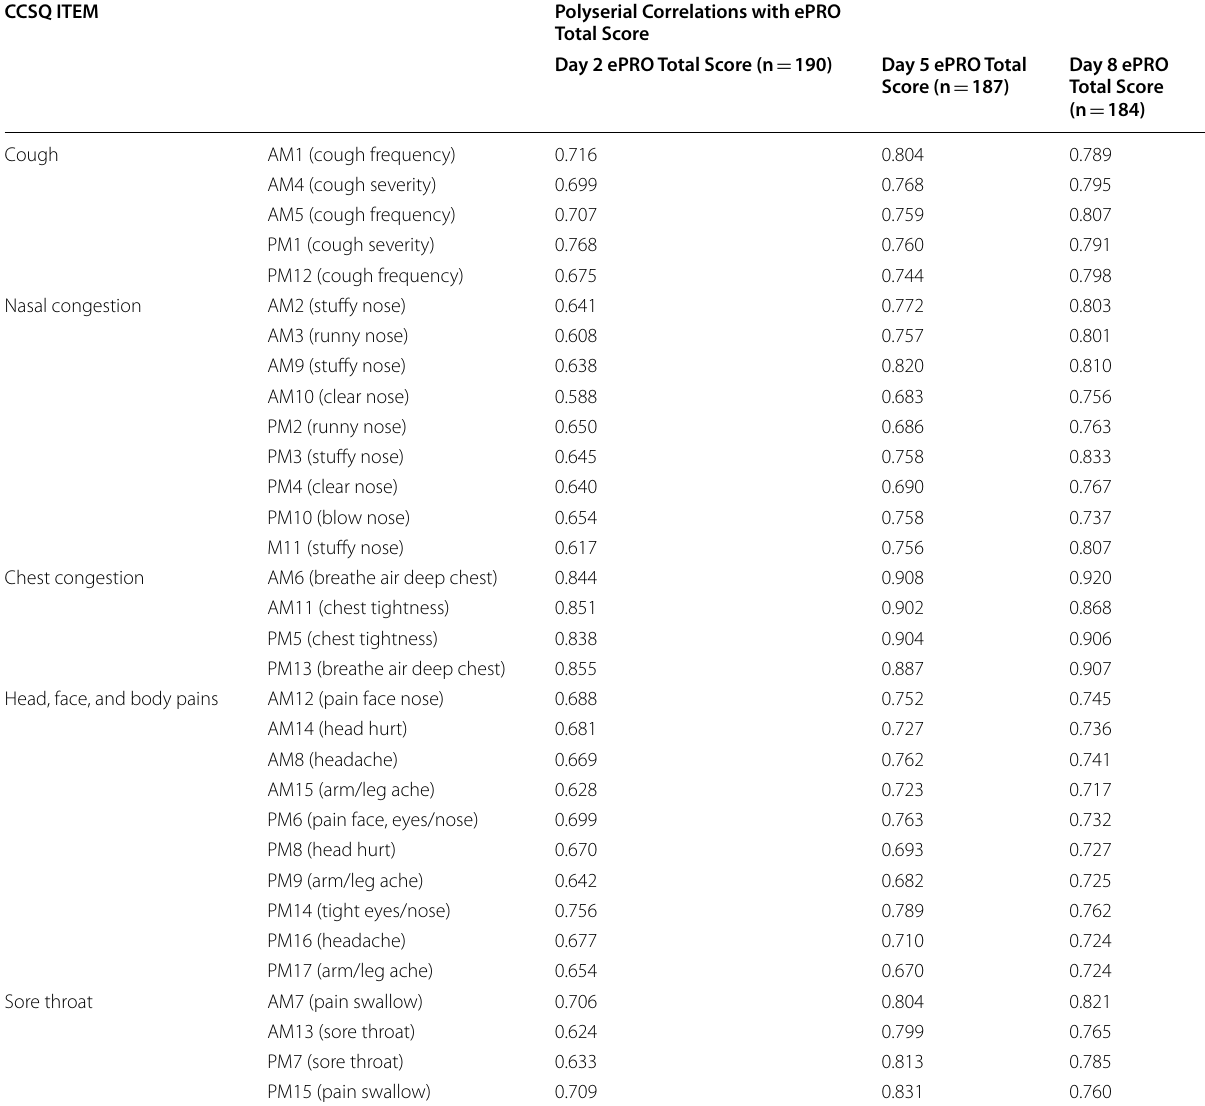
Table 6 Concurrent validity: polyserial Correlations between the chest-related ePRO total summary score and the CCSQ for all participants (N =